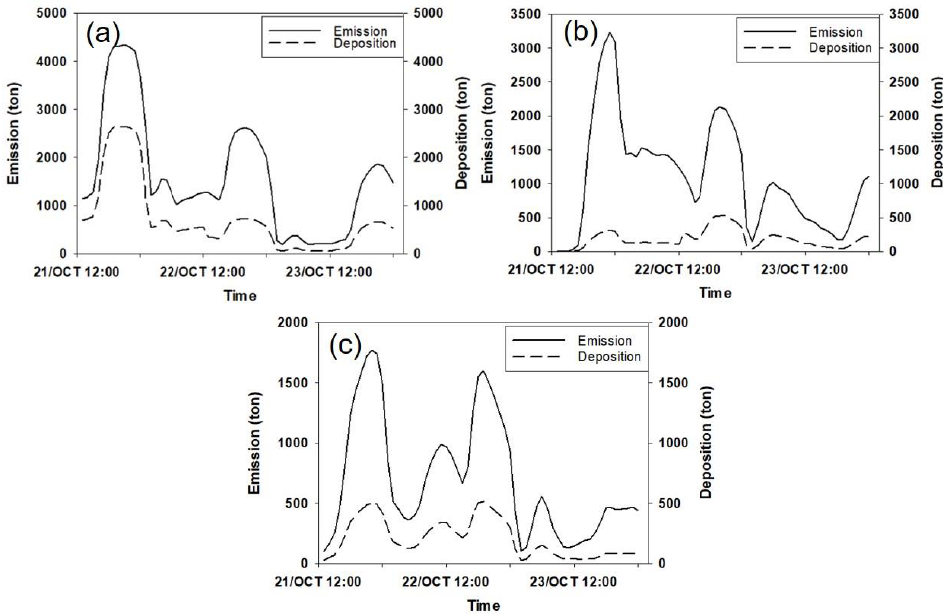
Figure 9. Time series of dust emitted along with the dust deposition estimation in the Gulf of California in (a) Altar Desert area (b) Sonora coast area and (c) a delimited area between the Altar Desert and the Sonora coast area. Table 3. Results of estimation of dust deposition in the Gulf emitted by the areas of case 1 (Altar Desert) and case 2 (Sonora coast).